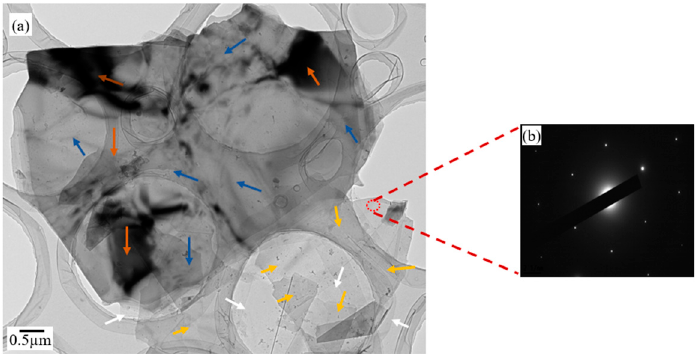
Figure 5. ( a ) TEM image of graphene platelets after one-hour ultrasonication and ( b ) electron dif- fraction pattern of a randomly selected area.